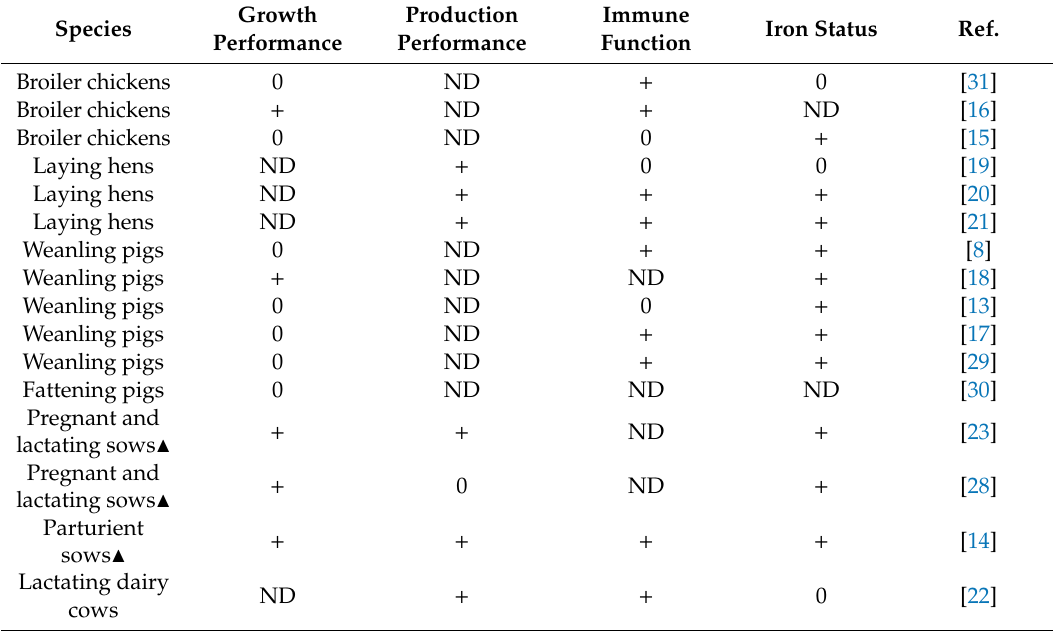
Table 1. E ff ects of 5-aminolevulinic acid (5-ALA) supplementation on di ff erent farm